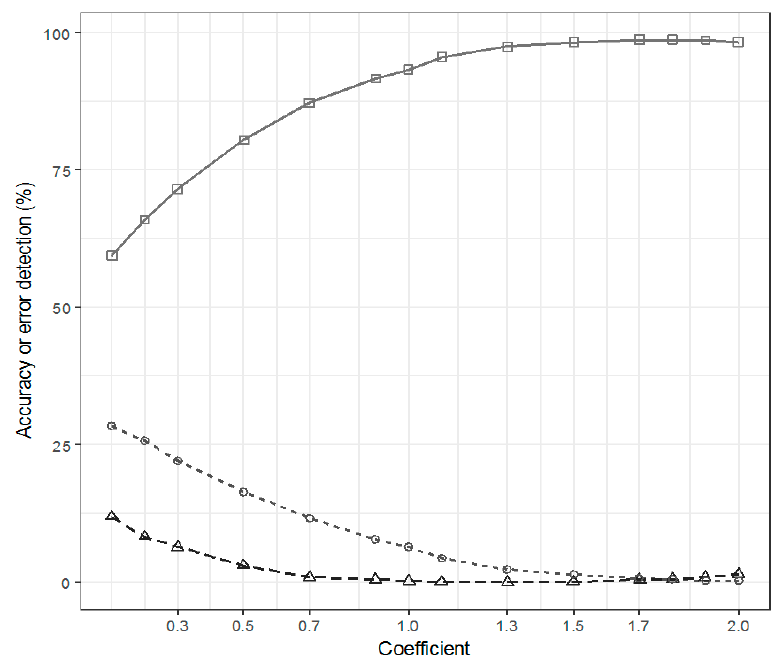
Figure 6. The overall accuracy, false detection and missed detection of MAD variate-2 derived from an Iteratively Reweighted Multivariate Alteration Detection for consecutive multiplier constants of standard deviation between 0.1 and 2.0 to determine threshold for change detection.